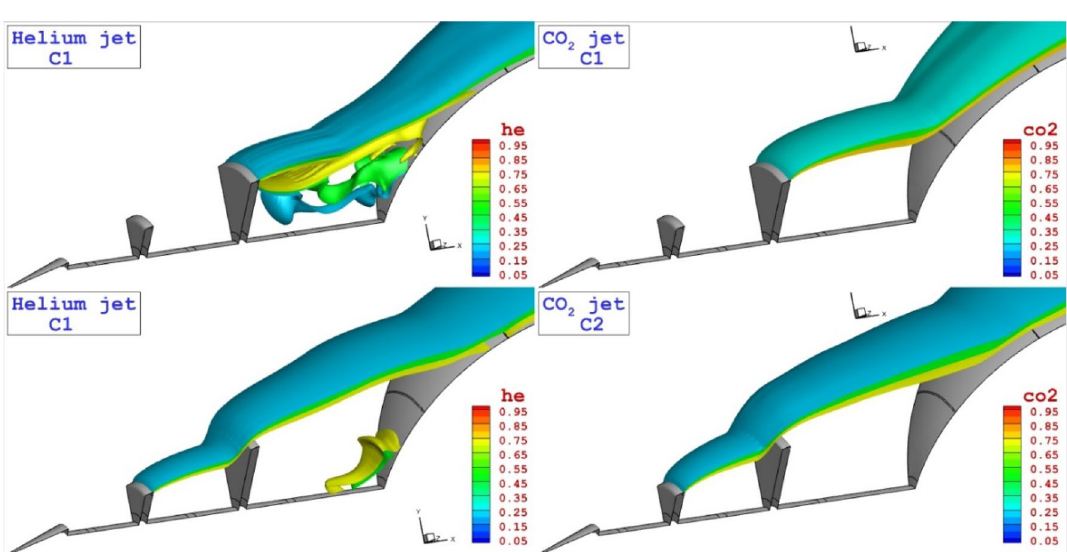
Figure 7. Three-dimensional flow feature with coolant